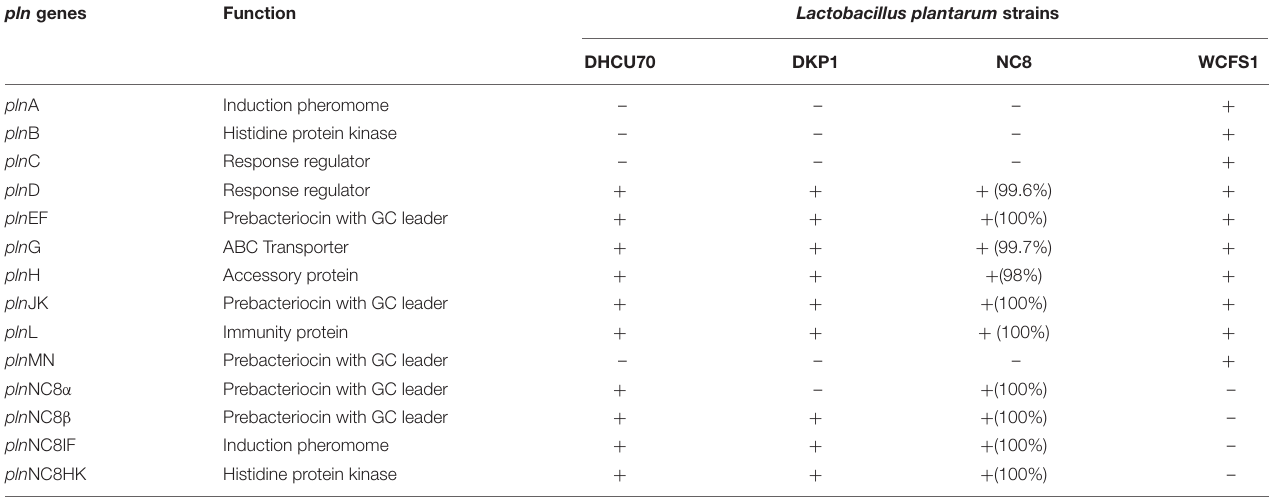
TABLE 3 | Probiotic related genes present in Lactobacillus plantarum strains DHCU70 and DKP1. Gene